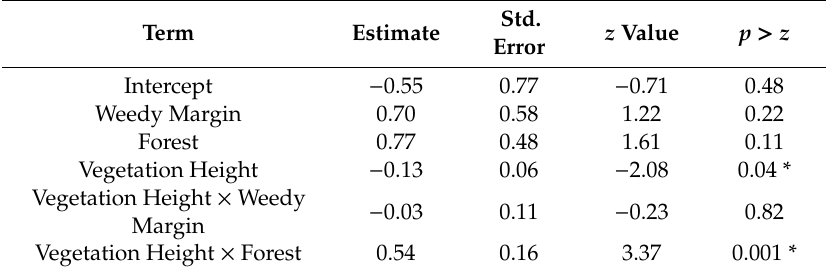
Table 6. Parameter estimates for the model used to analyze the e ff ects of habitat and vegetation height on the abundance of A. americanum nymphs. Std. z Value p > z Term Estimate Error Intercept − 0.55 0.77 − 0.71 0.48 Weedy Margin 0.70 0.58 1.22 0.22 Forest 0.77 0.48 1.61 0.11 Vegetation Height − 0.13 0.06 0.04 * Vegetation Height × Weedy − 0.03 Margin Vegetation Height ×